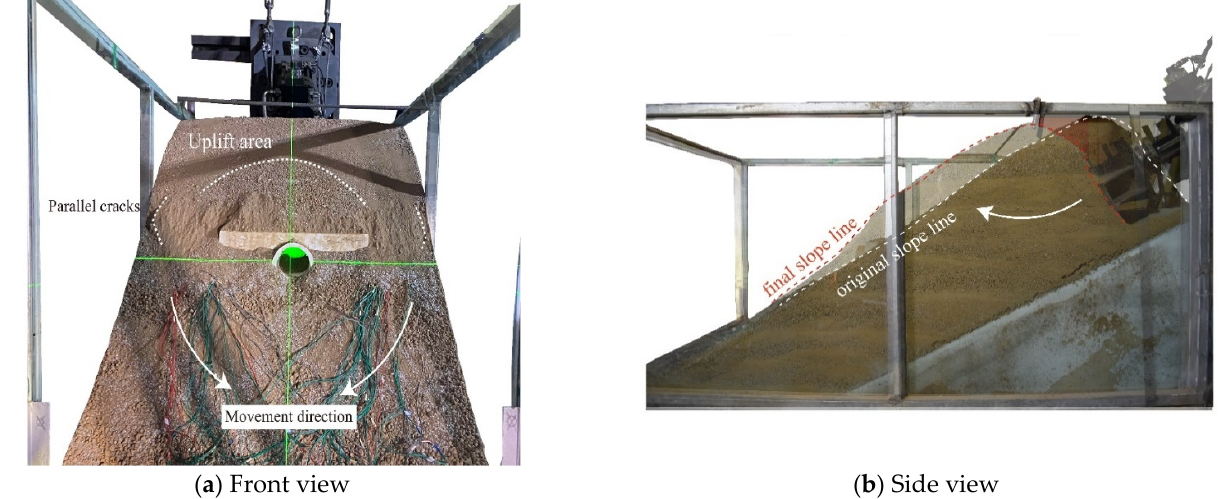
Figure 14. Deformation characteristics of the slope at the end of the test loading.